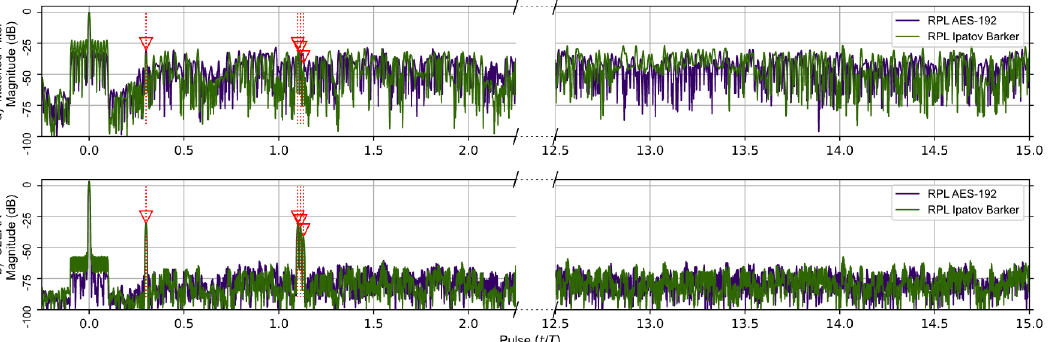
Figure 7. RPL AES-192 method (Purple) and RPL Ipatov–Barker method (Green) matched filter’s response for 78 simulated pulses. ( a ) Top, matched filter’s response before CLEAN. ( b ) Bottom, CLEAN reconstructed matched filter’s response when applied to all targets. The noisy side lobes are significantly reduced by CLEAN revealing all buried targets.